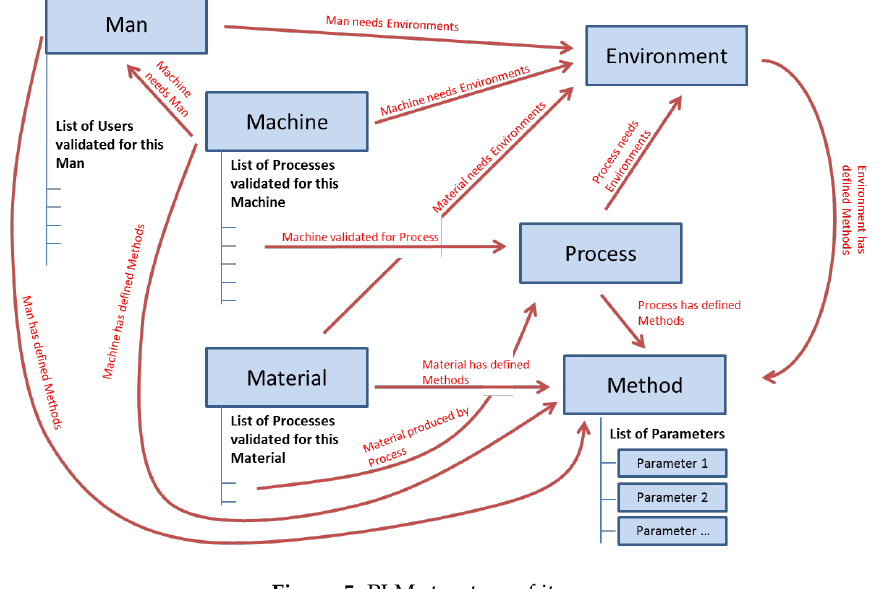
Figure 5. PLM structure of items.